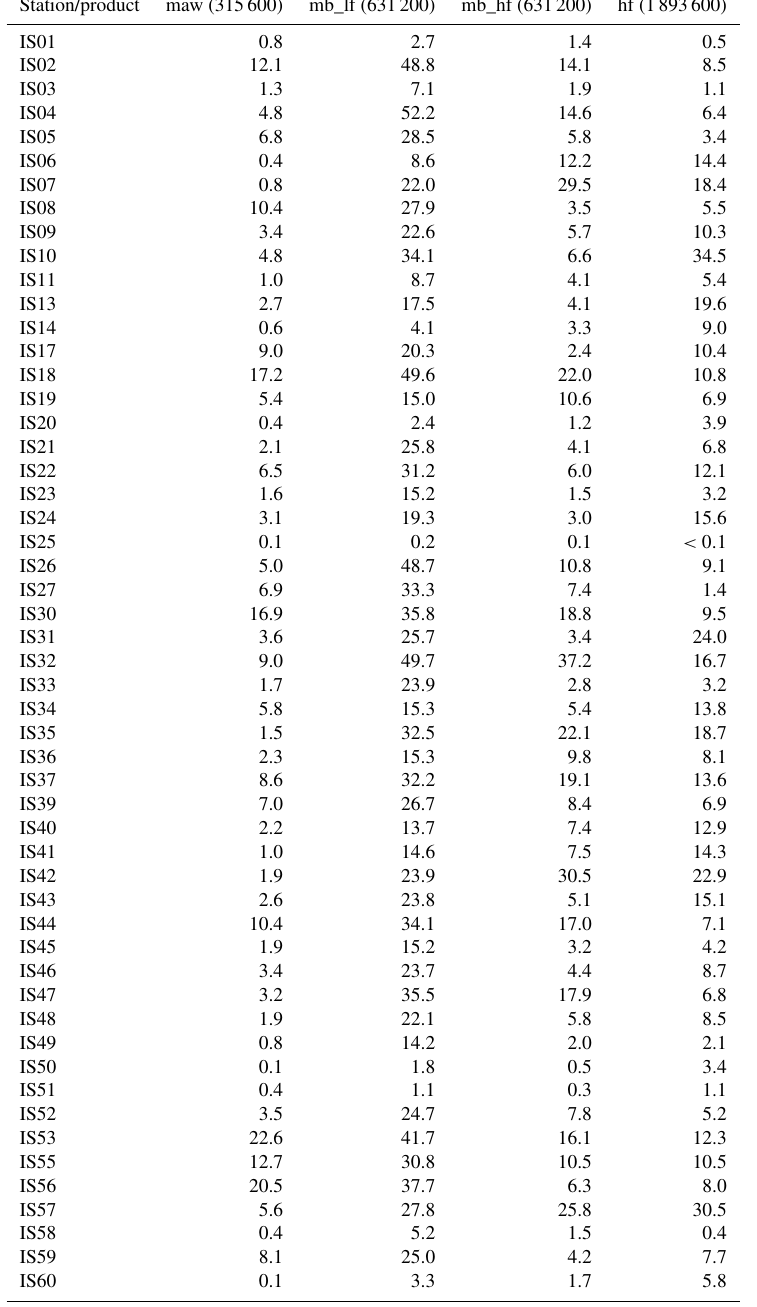
Table B1. Product availability per station ( N avail ) in percent of the total number of time steps over 18 years ( N time ; in parentheses). For example, an availability of 2.7% means that signals were present for 2.7% of the total 18 years (2003–2020). More precisely, a product is available for this portion of all time steps considered, e.g., with 30min temporal resolution for the maw product, the number of time steps amounts to 315600 over 18 years and 2.7% would be 8521 time steps with detection parameters available for a station. The data availability rate thus depends on multiple factors, such as the operational time of a station, data gaps, the actual arrivals of coherent signals, and PMCC performance, to name the most relevant